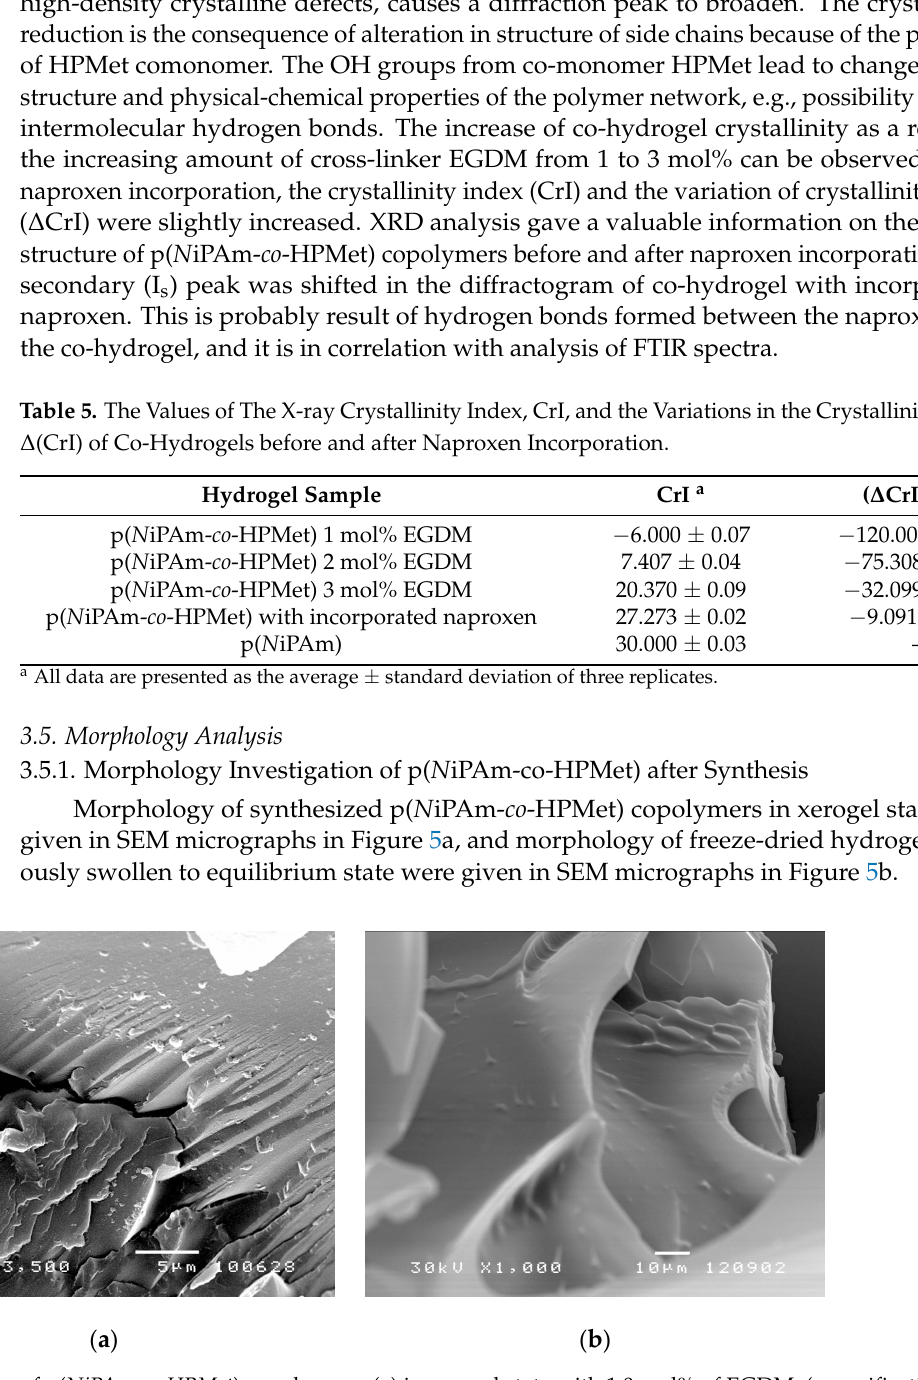
Figure 5. SEM micrographs of p( NiPAm-co-HPMet ) copolymers: ( a ) in xerogel state with 1.0 mol% of EGDM, (magnification 3500×, scale bar 5 µm) and ( b ) freeze-dried hydrogels swollen to equilibrium state with 3.0 mol% of EGDM (magnification 1000×, scale bar 10 µm).